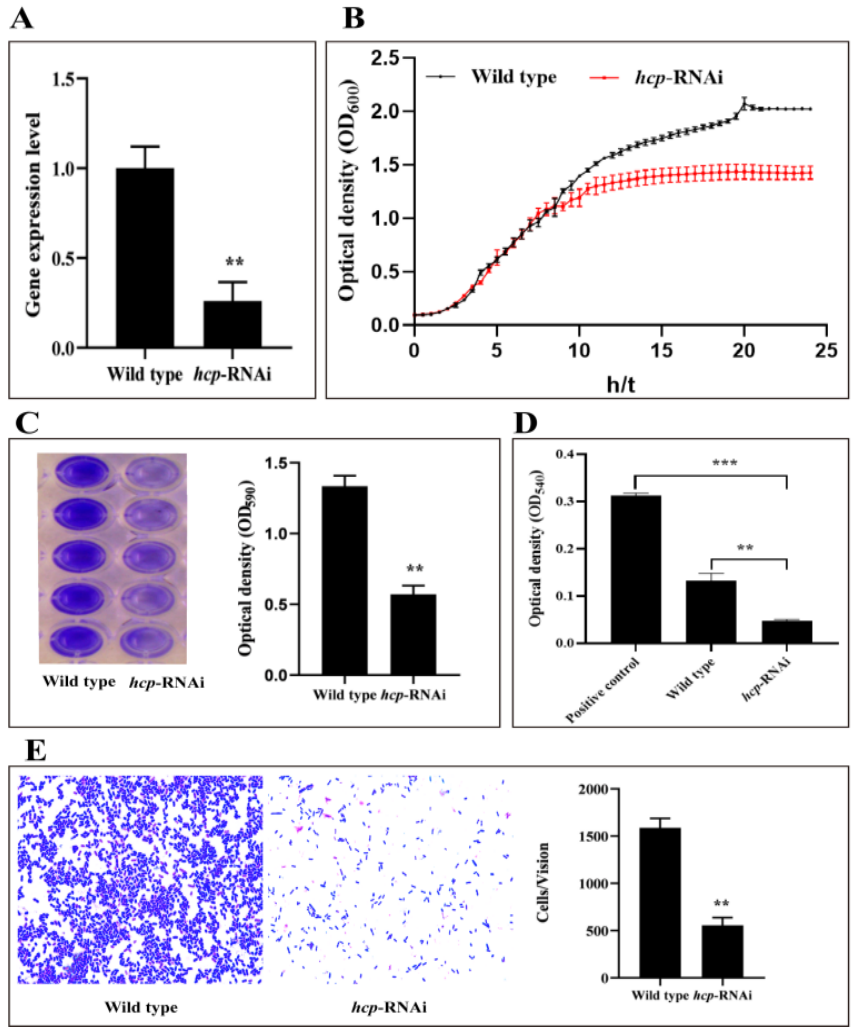
Figure 4. Effects of hcp gene silencing on the virulence phenotype of A. salmonicida . ( A ) Expression levels of hcp in wild-type and hcp -RNAi strains identified by qRT-PCR. Data are shown as mean ± SD from three independent biological replicates. ( B ) Effects of hcp gene silencing on the growth of A. salmonicida . Data are shown as mean ± SD from six independent biological replicates. ( C ) Determination of biofilm-forming ability. ( D ) Determination of hemolysis. ( E ) Determination of adhesion ability. Data are presented as mean ± SD. Three independent biological replicates were performed per group. ** p < 0.01, *** p < 0.001.